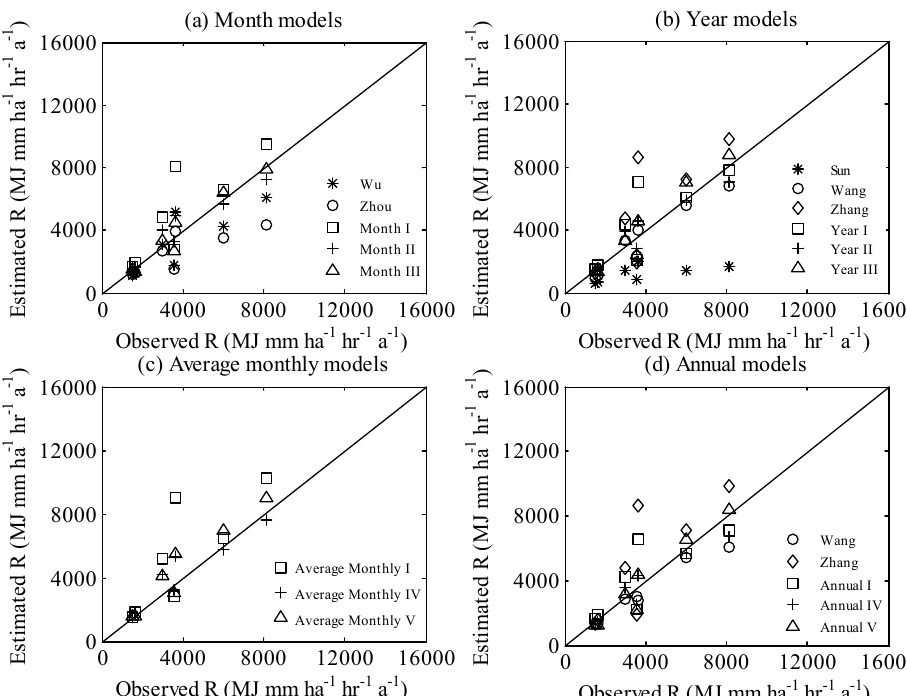
Figure 5. Comparisons of the estimated R factor value calculated based on (a) month, (b) year, (c) average monthly, and (d) average annual models using 1min resolution data for the seven independent validation stations. Month models included models in Wu (1994), Zhou et al. (1995), and Month I, II, and III from this study. Year models included models from Sun et al. (1990), Wang et al. (1995; the one with MAPE sym of 20.3%), Zhang and Fu (2003), and Year I, II, and III from this study. Average monthly models included models from Average Monthly I, II, and III from this study. Average annual models included models from Wang et al. (1995; the one with MAPE sym of 13.2%), Zhang and Fu (2003; the one with MAPE sym of 34.6%), and Annual I, II, and III from this